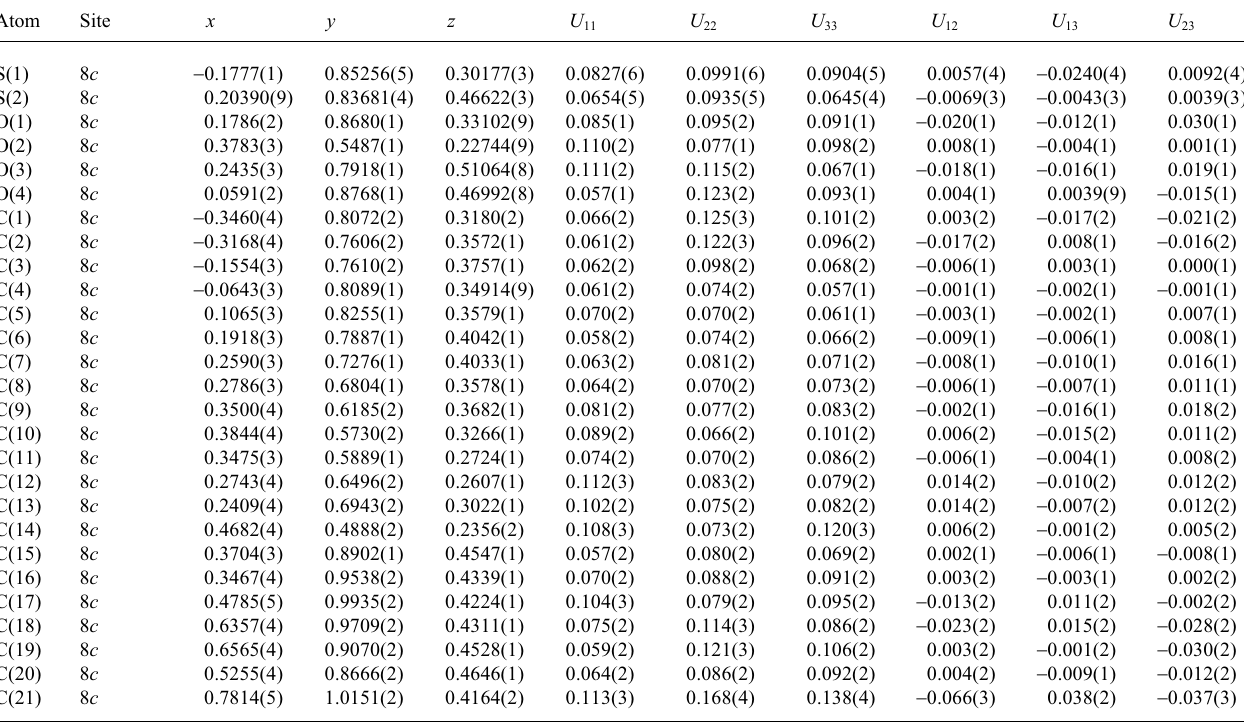
Table 3. Atomic coordinates and displacement parameters (in Å 2 )